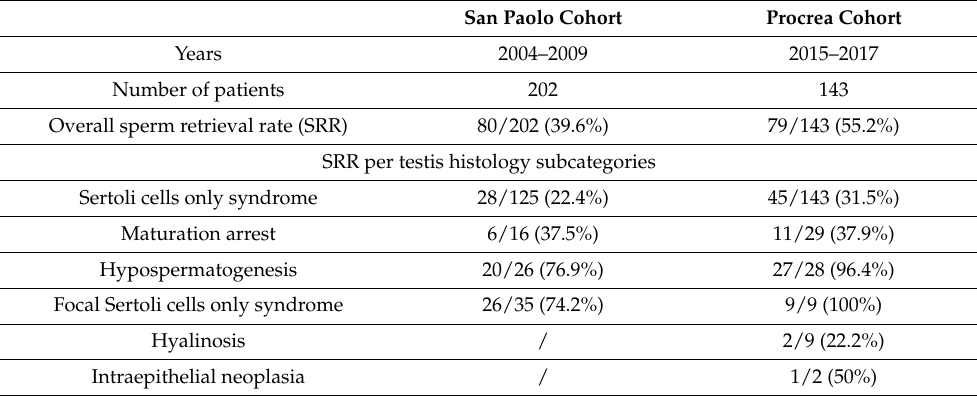
Table 1. Comparison of the mTESE outcome performed by the same urologist (GMC) in two cohorts of patients with